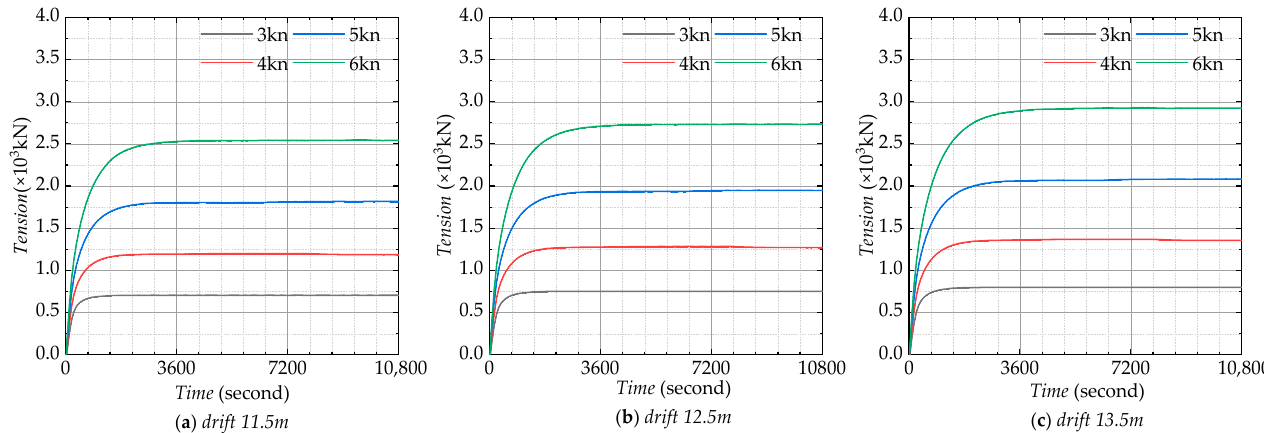
Figure 12. Towrope tension at different drift depths and towing speeds.